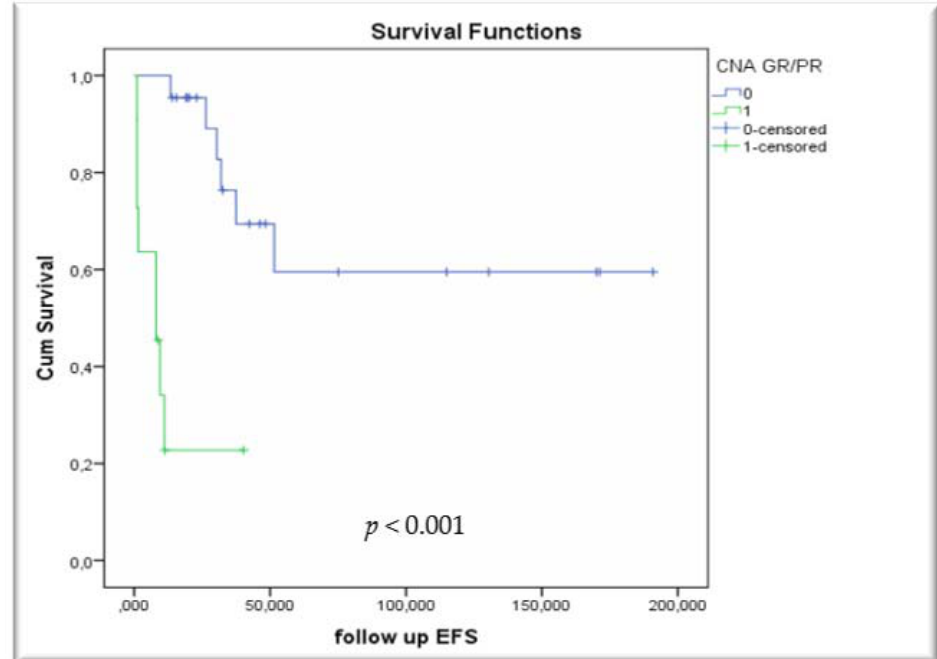
Figure 3. Survival rates by CNA risk index, integration with FC-MRD on days +15 and +33 and further stratification within FC-MRD positive and negative subgroups. ( A ) EFS by CNA profile among FC-MRDd15+ patients, ( B ) EFS by CNA profile among FC-MRDd33+ patients, ( C ) EFS by CNA profile among FC-MRDd33- patients, ( D ) EFS by MRDd33 status among GR-CNA patients, ( E ) EFS by MRDd33 status among PR-CNA